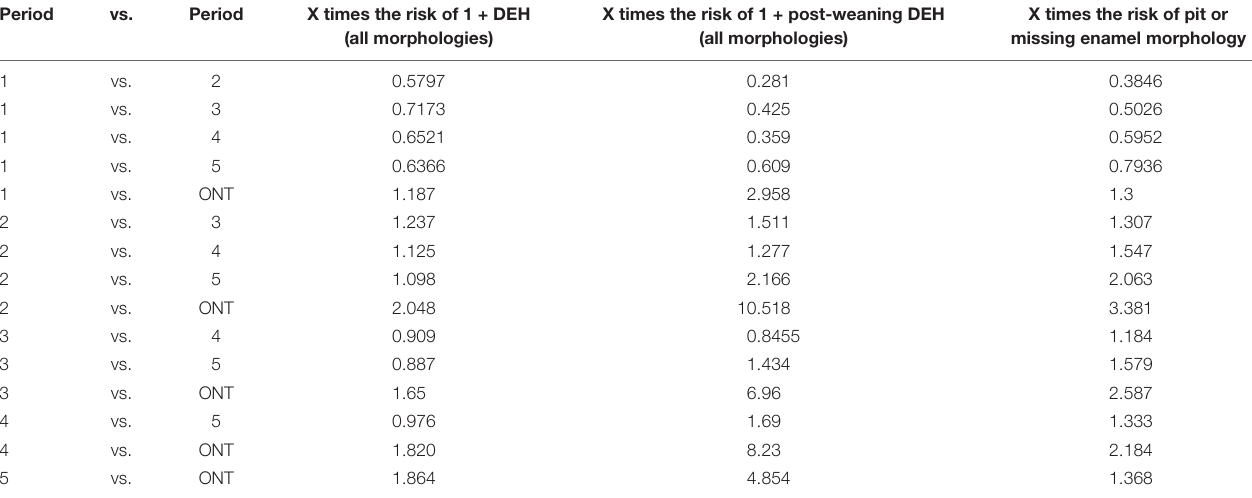
The relative risk of pit and missing enamel DEH reflects the occurrence of more severe and longer-lasting stress than the relative risk of all DEH types. IRNP, Isle Royale National Park; ONT, closest mainland Ontario moose.